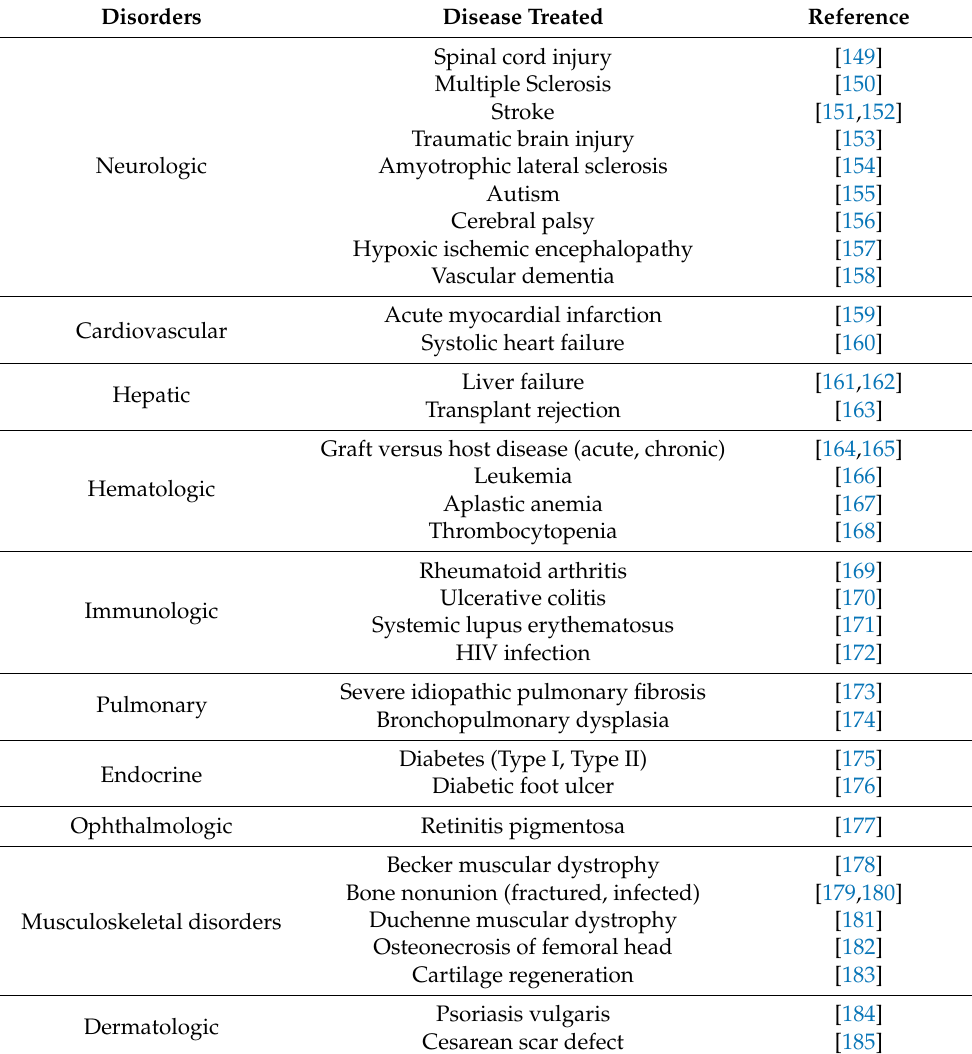
Table 2. Summary of clinical applications of umbilical cord mesenchymal stromal